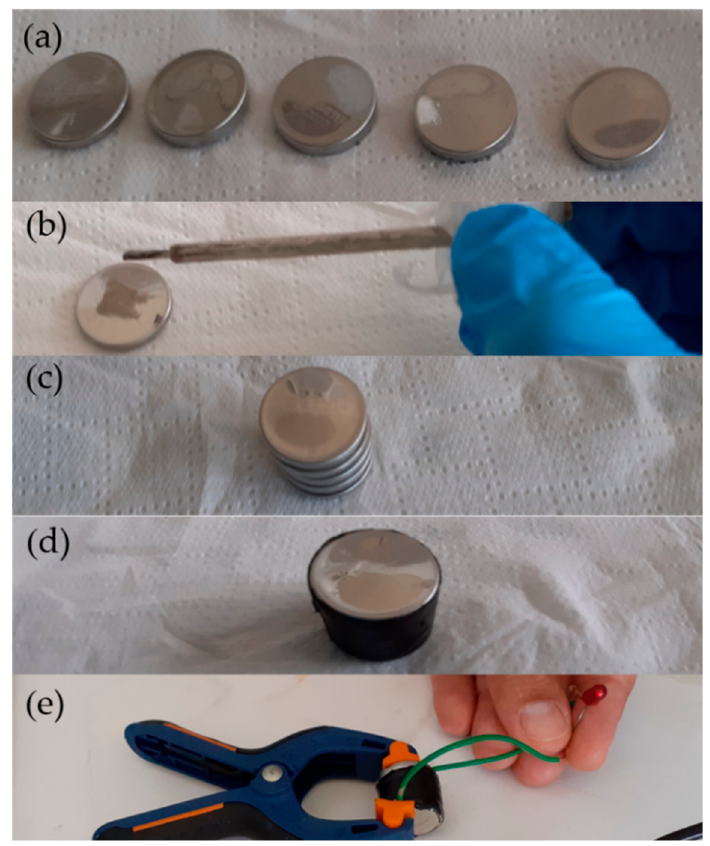
Figure 17. Assembly process for a 4.5 V coin cell stack ( a ). The cells were connected in series ( b , c ) and assembled and insulated by means of non-conductive tape ( d ), and tested with an LED ( e ) that was maintained functional during the expected discharge time of the